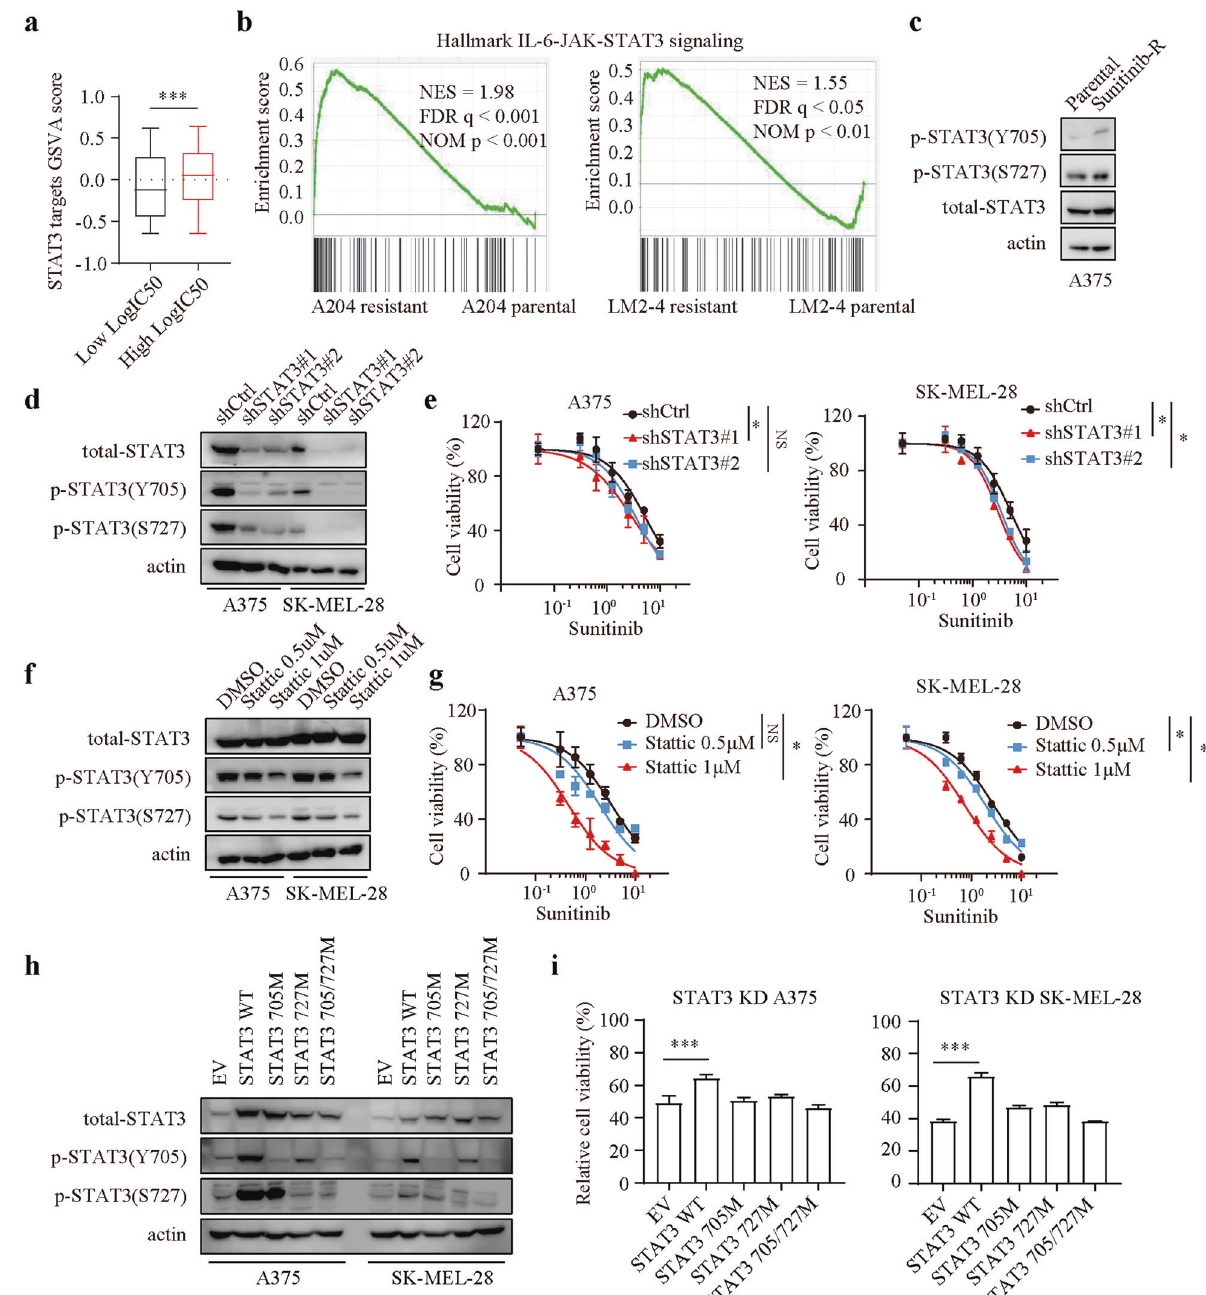
Fig. 3 STAT3 regulates sunitinib sensitivity in melanoma cells through its phosphorylation. a GSVA scores of STAT3 targets in cells with a high IC50 of sunitinib or a low IC50 of sunitinib from the Cancer Therapeutics Response Portal dataset. b GSEA of the hallmark IL6/JAK/ STAT3 signaling pathway in the indicated parental and sunitinib-resistant cells. c Western blot analysis of the indicated proteins in parental and sunitinib-resistant A375 cells. d Western blot analysis of the indicated proteins in shCtrl and shSTAT3 melanoma cells. e Dose response of sunitinib-induced death in shCtrl and shSTAT3 melanoma cells over a 24 h period. f Western blot analysis of the indicated proteins in A375 and SK-MEL-28 cells after treatment with DMSO, 0.5 μ M stattic, or 1 μ M stattic for 24 h. g Dose response of sunitinib-induced death in A375 and SK- MEL-28 cells in the presence of DMSO, 0.5 μ M stattic, or 1 μ M stattic for 24 h. h Western blot analysis of the indicated proteins in shSTAT3 A375 and SK-MEL-28 cells after the expression of the empty vector, wild-type STAT3 plasmid, or STAT3 phosphorylation mutant plasmids. i Viability of the indicated cells after treatment with sunitinib for 24 h. Two-tailed unpaired Student ’ s t test was performed in ( a ). Nonlinear regression was applied in ( e and g ). P values were calculated using one-way ANOVA in ( i ). *** P < were dramatically inhibited by cotreatment with BET inhibitors and progression was signi fi cantly inhibited in the combination group sunitinib (Fig. 2b, c). Among these genes, Cyclin Dependent Kinase 1 compared with the other groups (Fig. 2a). To determine which genes (CDK1) is best known for its function as a master regulator of the cell were suppressed in the cell cycle gene set, we drew a Venn diagram cycle 24 . Cell division cycle 6 (CDC6) is an essential regulator of DNA and heatmap and found that 17 genes associated with the cell cycle